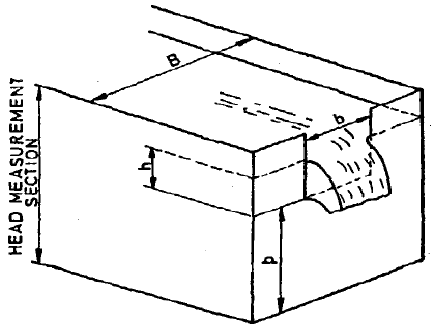
Figure 3. Rectangular